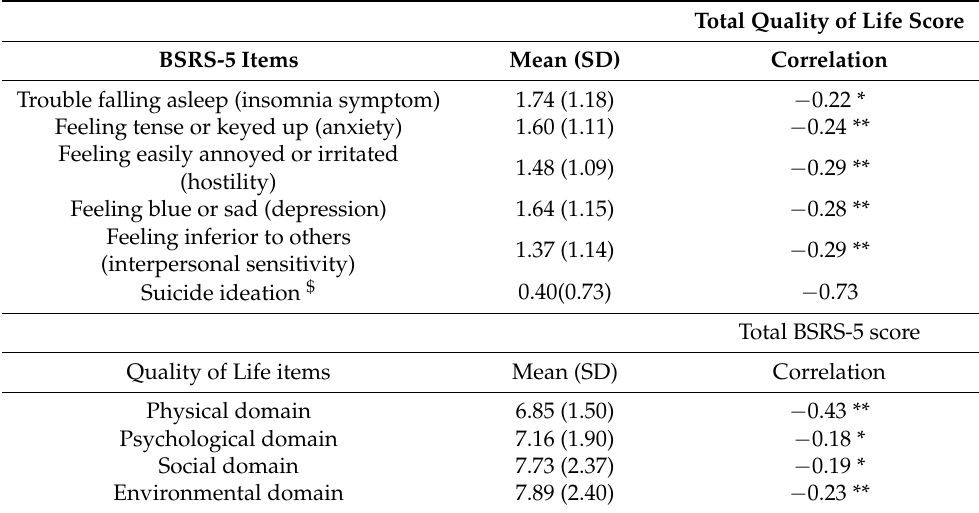
Table 4. Correlations between items on the BSRS-5 and Quality of Life with total score ( n = 124).